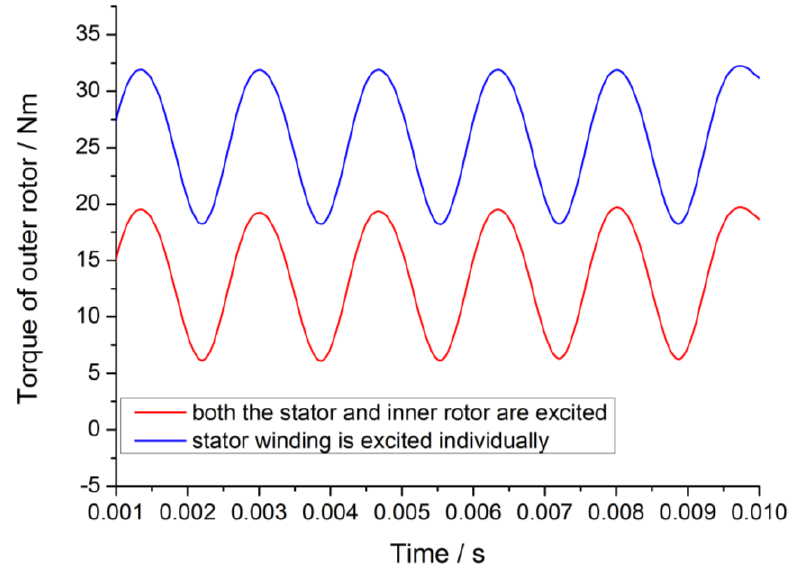
Figure 18. The torque waveforms of the outer rotor in different cases.